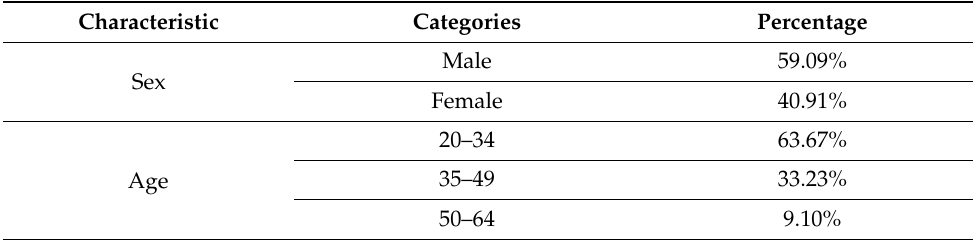
Table 2. Distribution of the sample with respect to age and